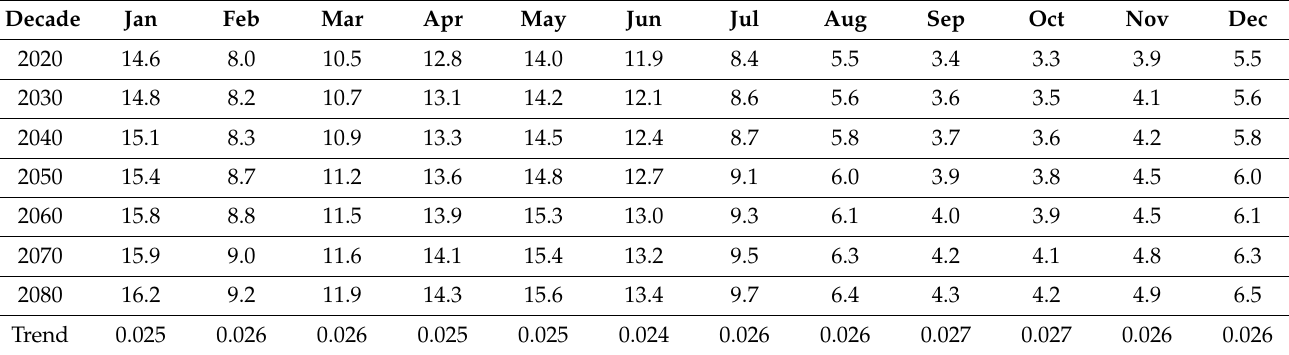
Table 6. Monthly mean temperature values per decade and their trend for Curarrehue, Chile, obtained from the application of the delta method to the coupled models (CMIP5) and for the average of the four routes of the Representative Concentration Trajectories (RCP) found in the 2014 IPCC